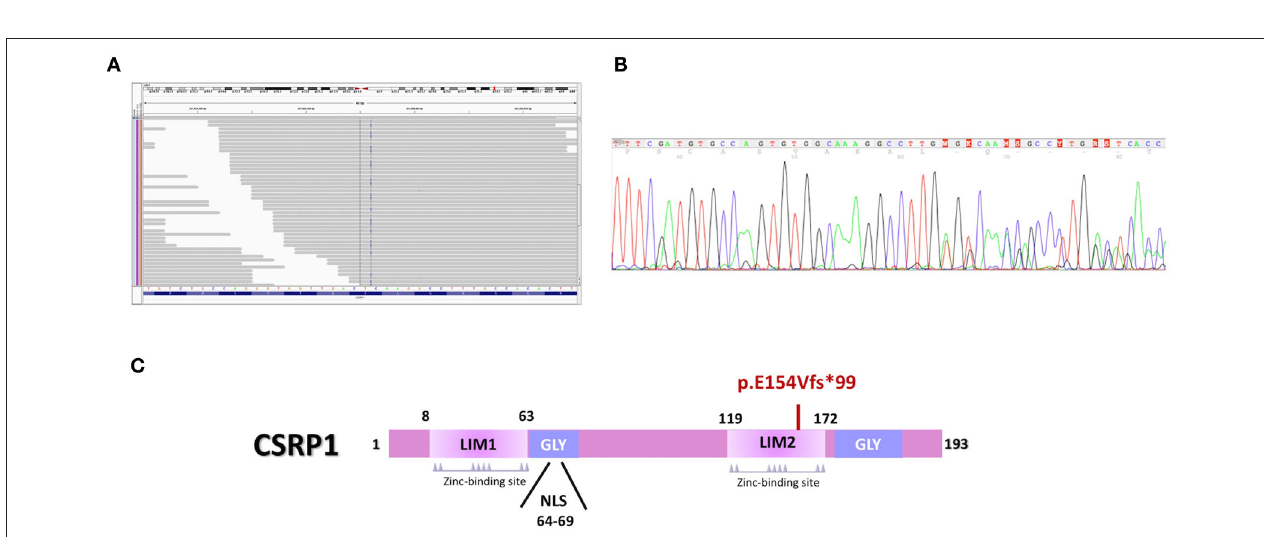
FIGURE 2 | The CSRP1 variant alters the structure of the protein. (A) Integrative genomics viewer (IGV) visualization of the targeted exome sequencing shows an insertion (Blue line) in Csrp1 gene. (B) Sanger Sequencing of the CSRP1 gene confirmed the 14 nucleotides duplication (TGTGGCAAAGGCCT) in exon 5. (C) Schematic representation of the mutation that abrogates the second LIM domain of the